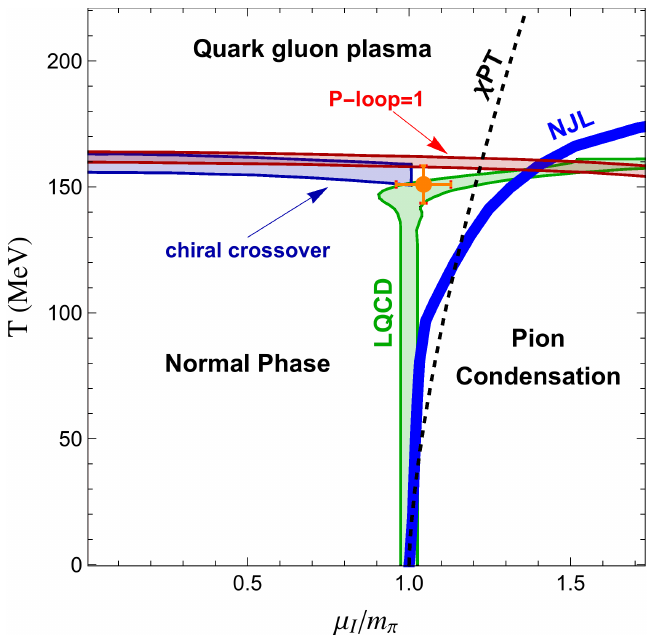
Figure 9. Phase diagram of hadronic matter at µ B = 0. The green shaded area marked with LQCD corresponds to the second order phase transition separating the pion condensed phase from the normal phase, at low temperature, and the chirally restored quark gluon plasma, at high temperature. These three phases meet at a (pseudo) tricritical point (orange dot with error bars), at T tricritical (cid:39) 151 MeV and µ I ,tricritical 140 MeV. The shaded blue area marks the chiral crossover line which (cid:39) in part overlaps with a (probable) deconfinement phase transition (shaded red area), see the text for more details. These results have been obtained in [133] by LQCD simulations. The NJL second order transition line (solid blue), see [38], overlaps with the LQCD data for T (cid:46) 100 MeV. Then it shows a stronger temperature dependence. The χ PT second order transition line (dashed black), corresponding to Equation (108), shows a temperature dependence that disagrees with both the LQCD and NJL